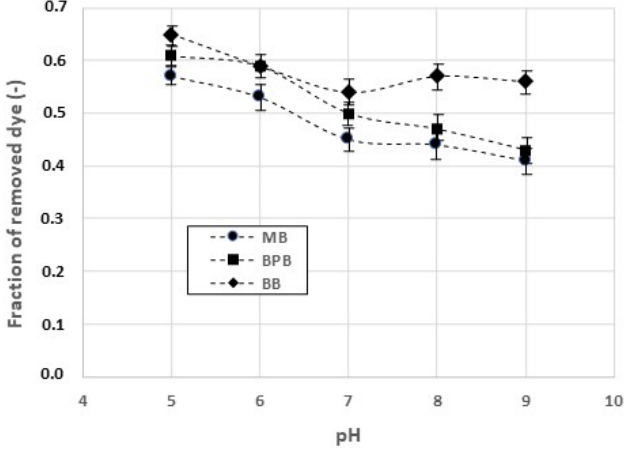
Figure 4. Amounts of methylene blue (MB), bromophenol blue (BPB), and Coomassie brilliant blue (BB) removed by laccases. Reaction time: 120 min.